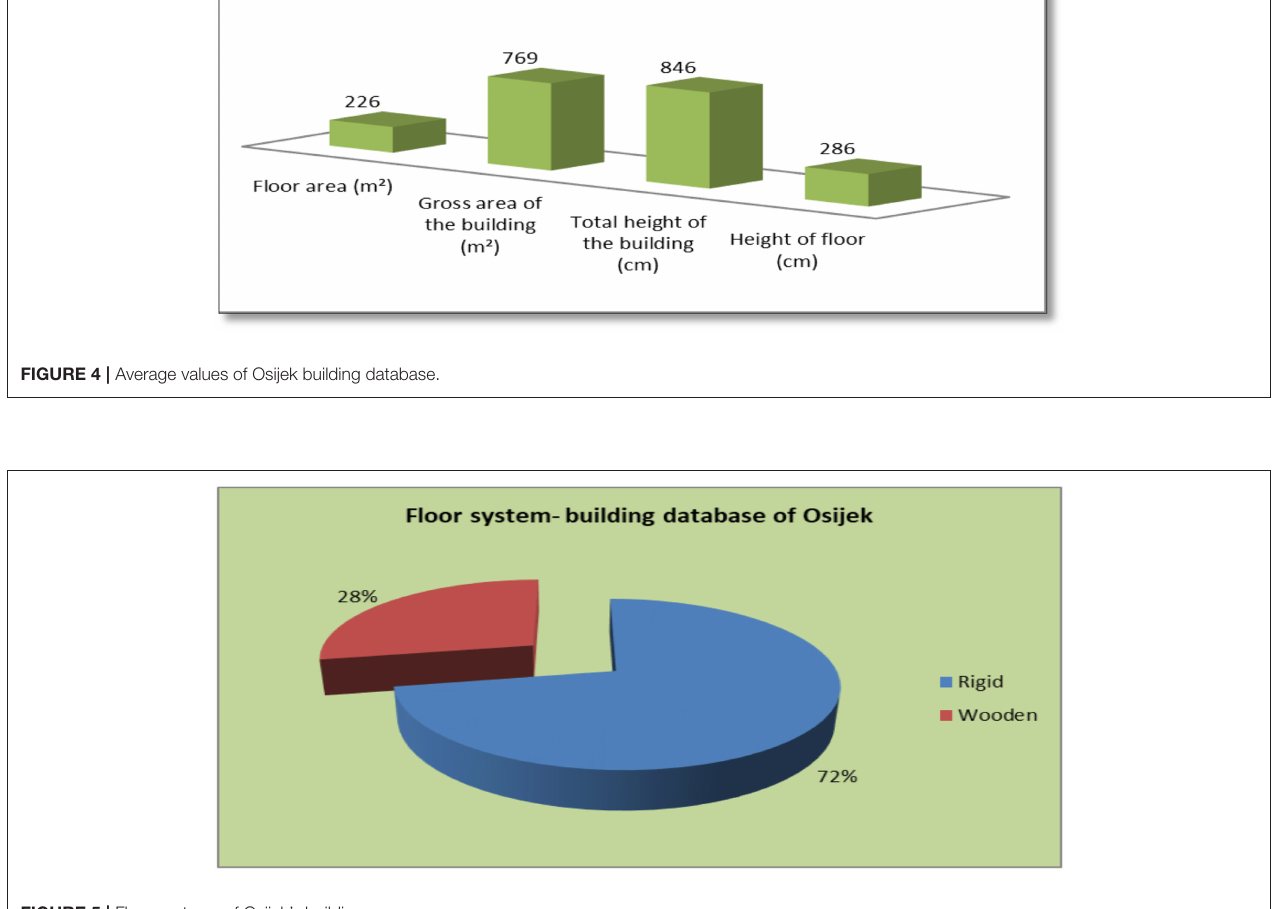
FIGURE 5 | Floor systems of Osijek’s buildings.